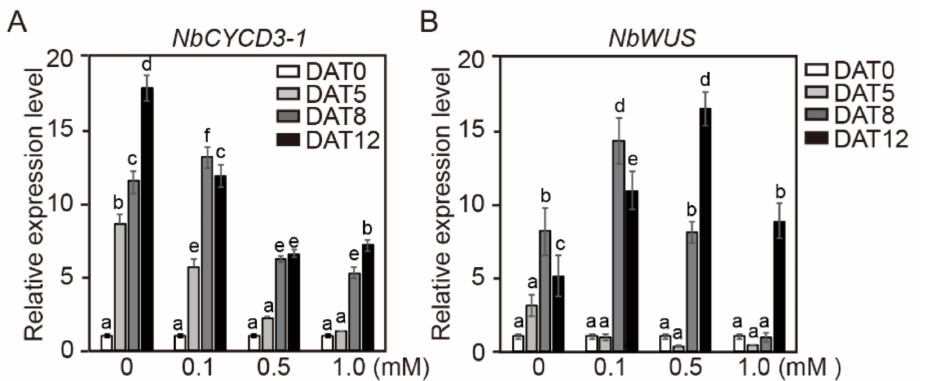
Figure 5. The relative expression levels of NbCYCD3-1 and NbWUS genes in cotyledon explants of tobacco after NaB treatment. The relative gene expression level of NbCYCD3-1 ( A ) and NbWUS ( B ) in cotyledon explants of tobacco cultured in shoot induction medium containing 0, 0.1, 0.5, and 1.0 mM of NaB. Data are representative of the results from three independent experiments. Error bars represent SD ( n = 3). Di ff erent letters on the bars indicate significant di ff erences between each treatment (ANOVA followed by a Turkey’s test, p < 0.05). DAT = day after treatment.